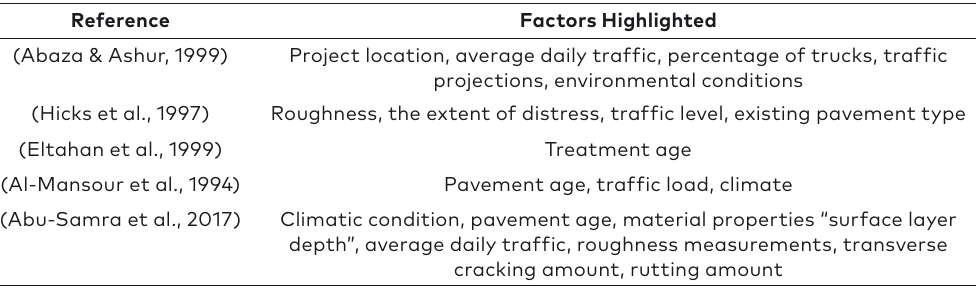
Table 2. Input parameters based on the previous studies